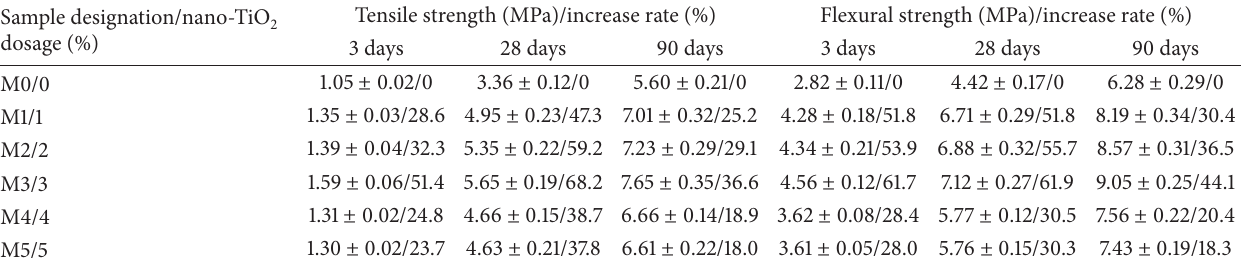
Table 3: Tensile and flexural strengths of mortars with different dosages of